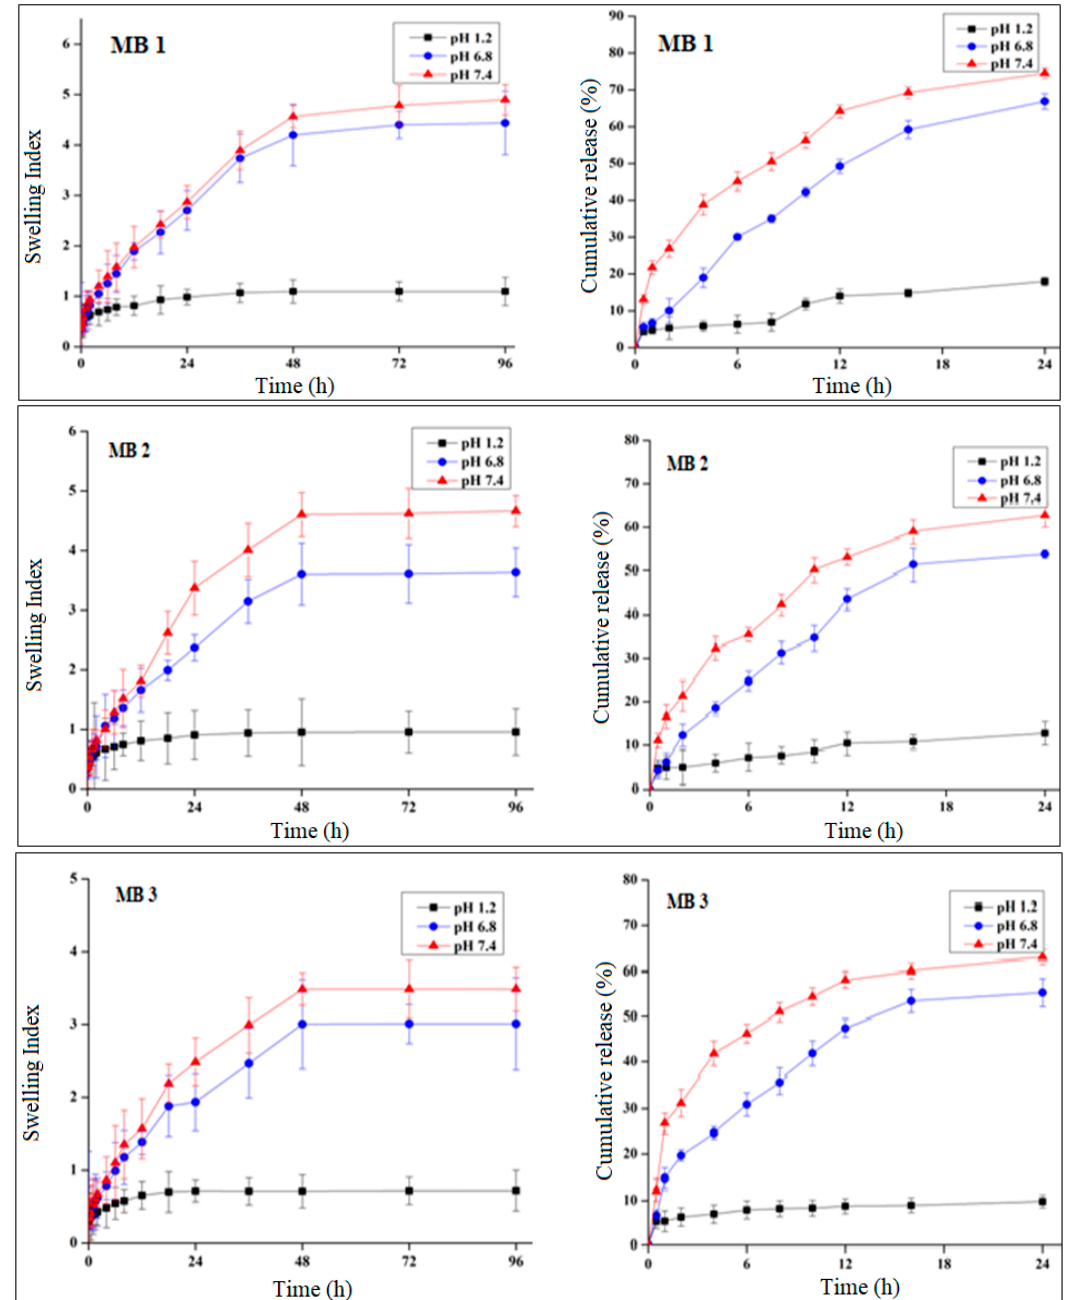
Figure 6. Swelling ratio and percentage drug release of formulation MB1-MB3.